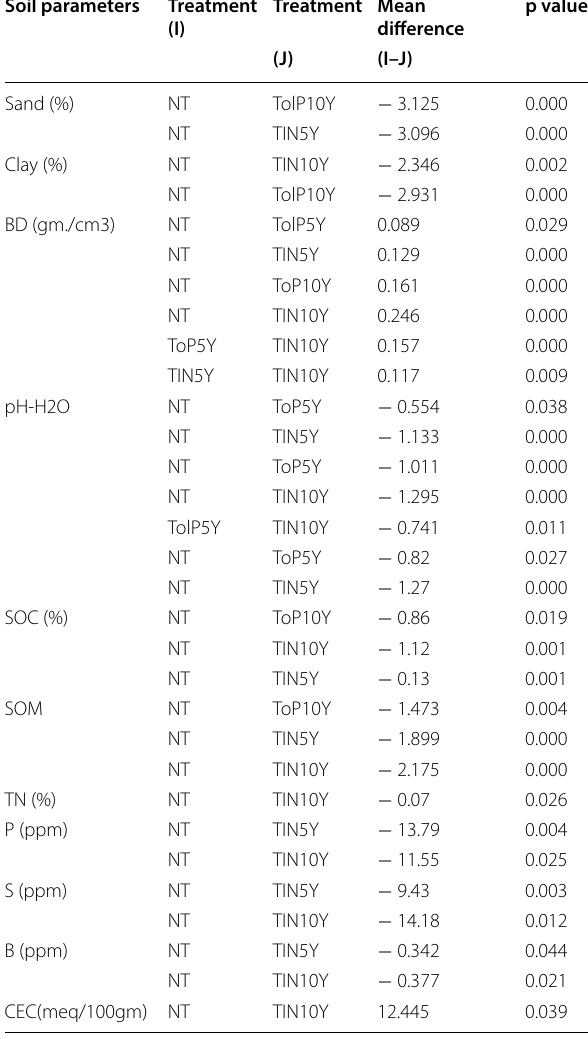
Table 6 Multiple-comparisons for selected soil quality indicators between treatment type and intervention years using the post hoc Turkey HSD test in the study